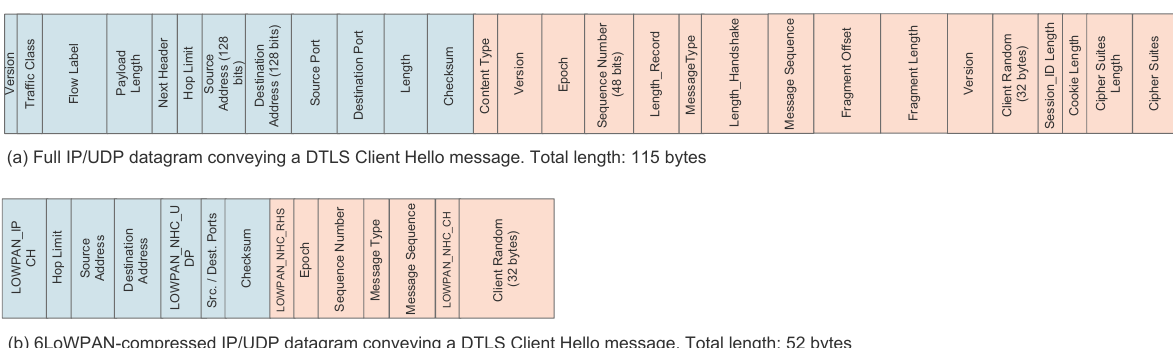
Figure 4. IP/UDP packet conveying a ClientHello message: ( a ) uncompressed, ( b ) compressed following the 6LoWPAN